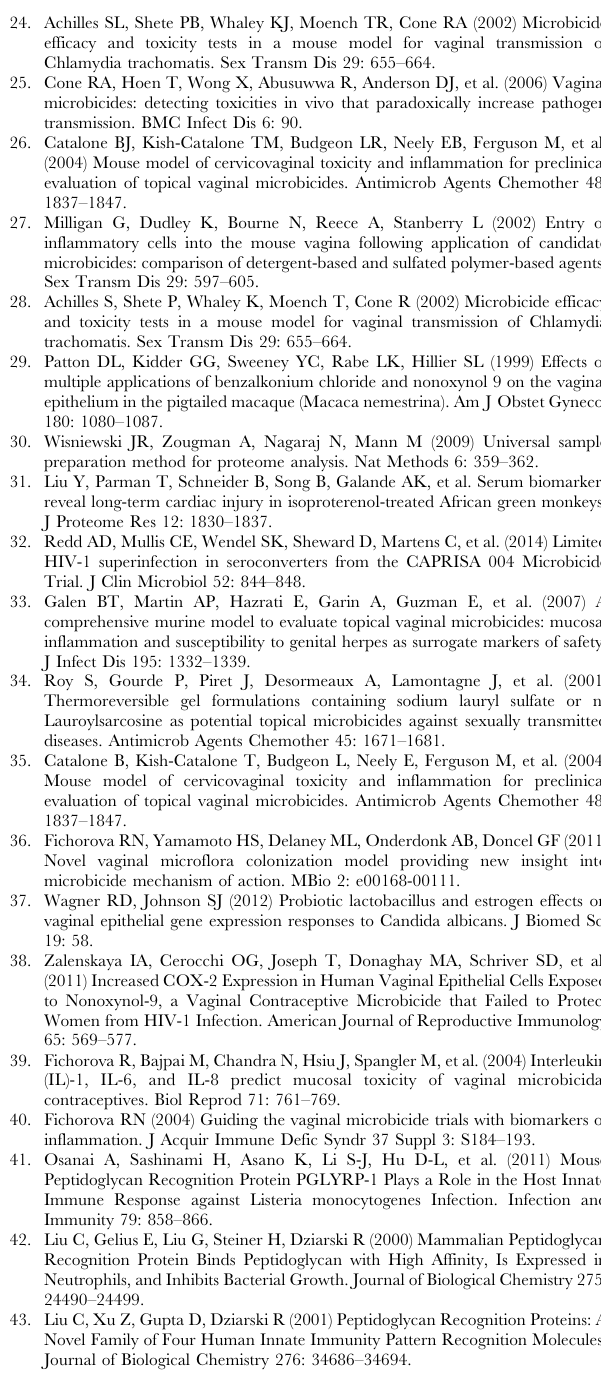
Table S1 List of RT-PCR primers. Table S2 List of biomarker candidates and their biological